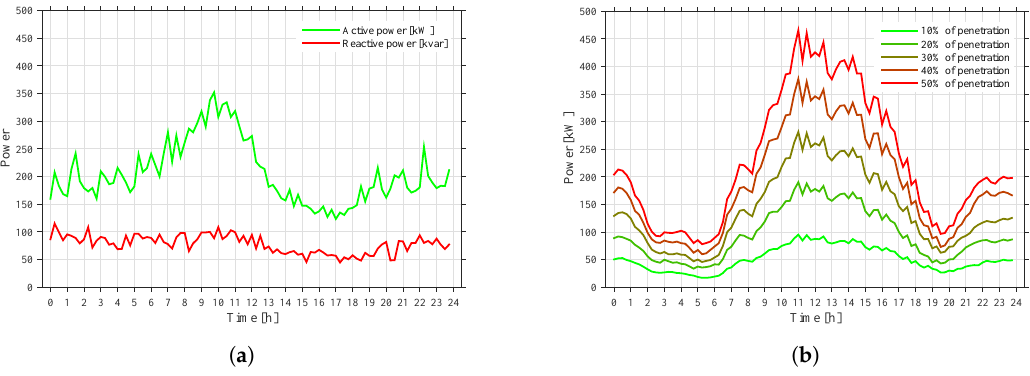
Figure 4. Input data. ( a ): Total active and reactive power consumption of the whole DN. ( b ): Total active power generated by DGs of the whole DN per different renewables’